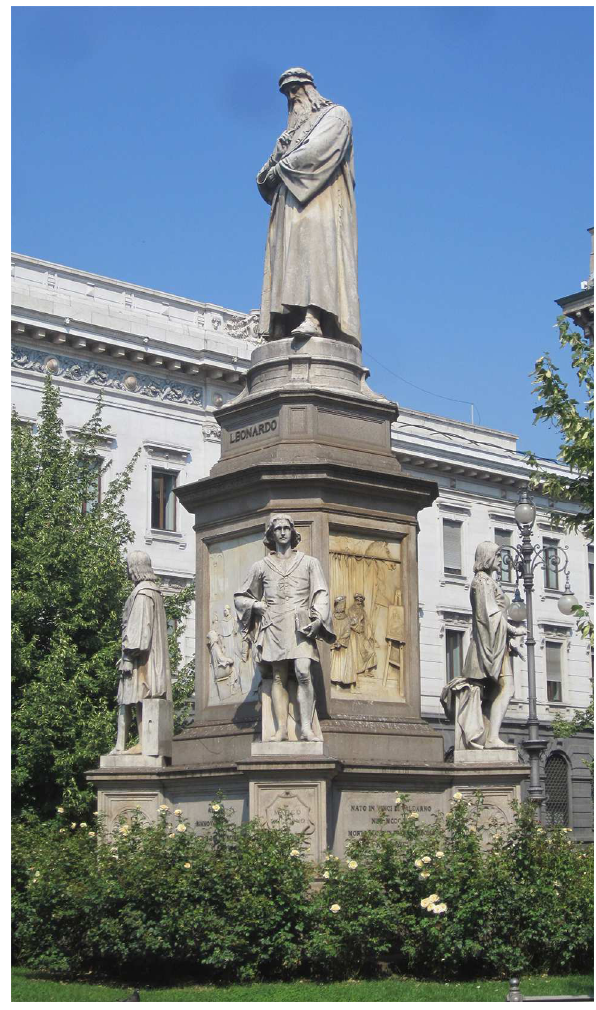
Figure 1. The statue of Leonardo da Vinci